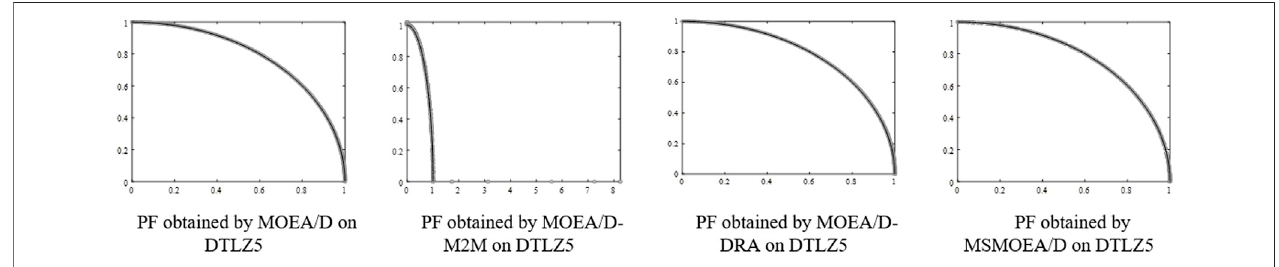
FIGURE 8 | PF obtained by MSMOEA/D and MOEAs on two-objective DTLZ5.